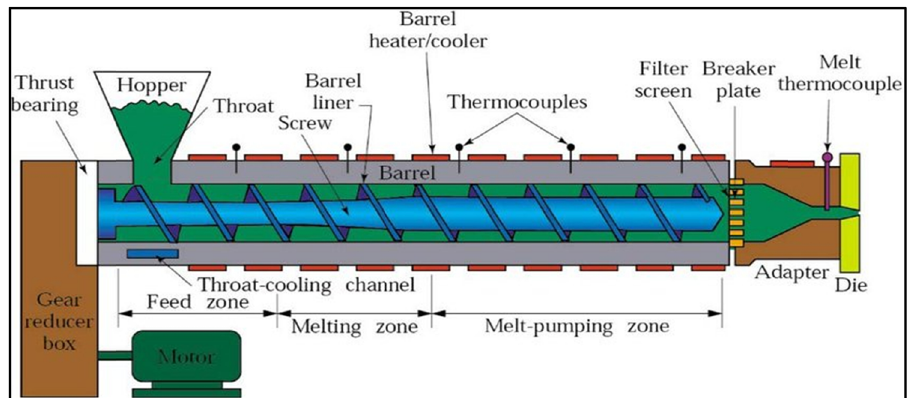
Figure 2: Extruder machine parts [ 28 ]